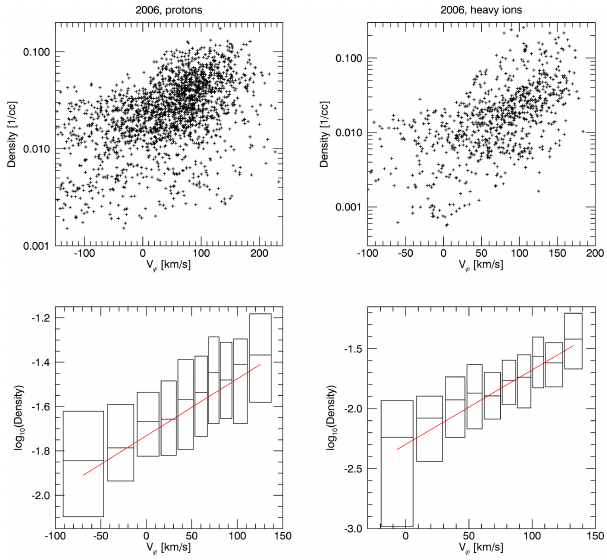
Figure 3. The same as in Fig. 2 but for year